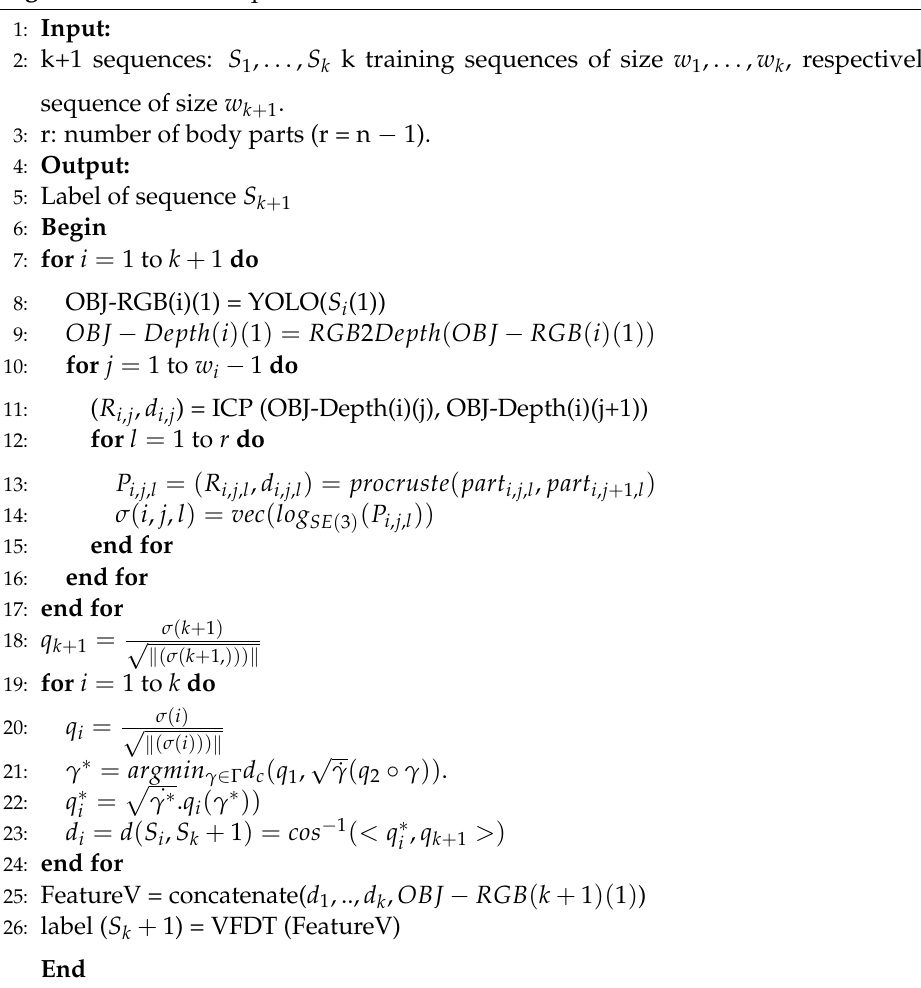
Algorithm 1 Action sequences’